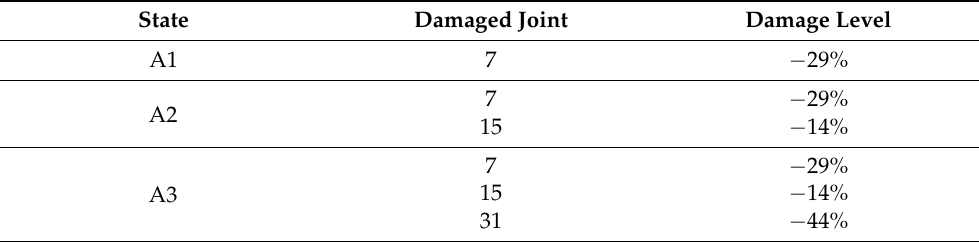
Table 3. Test case A.